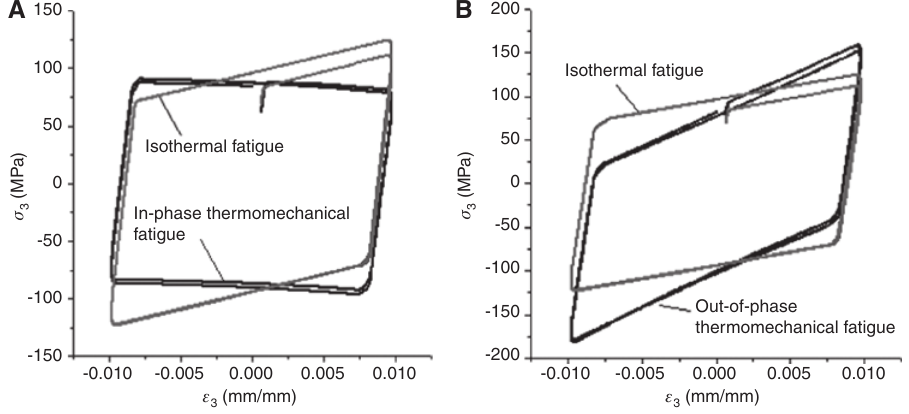
Figure 8: Stress-strain response under isothermal and thermomechanical loading: (A) in-phase and (B)